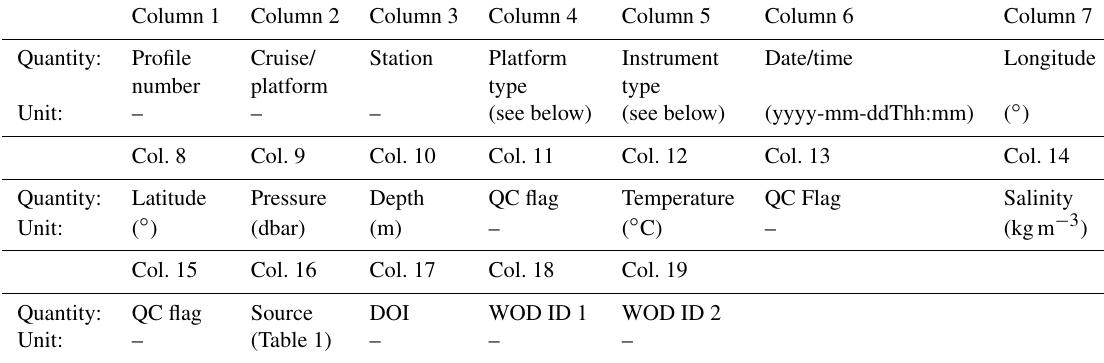
Platform abbreviations. S: ships, I: ice tethered, A: helicopters/airplanes, F: profiling floats, SU: submarines, C: ice camps, CO: coastal station, NA: unknown. Instrument abbreviations. CTD: conductivity–temperature–depth, XCTD: expendable CTD, B: bottle, STD: salinity–temperature–depth, XBT: expendable bathythermograph, MBT: mechanical bathythermograph, DBT: digital